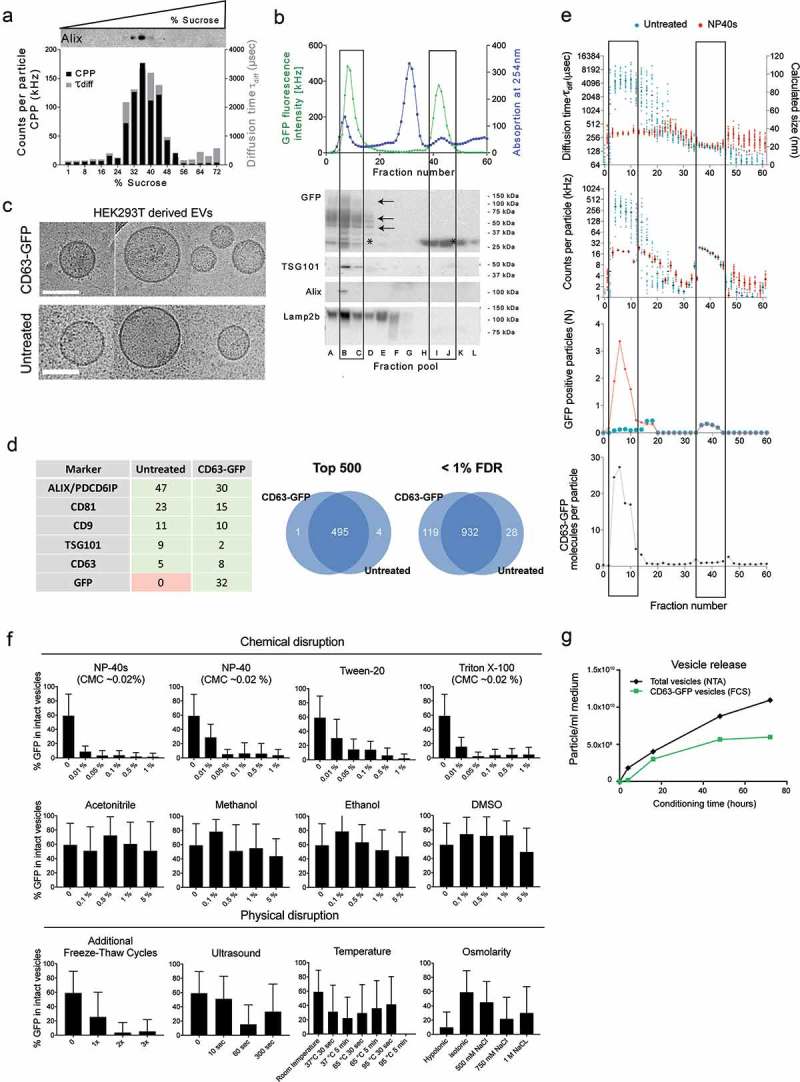
Single molecule – single vesicle characterization of CD63-GFP-tagged extracellular vesicles.(a) Direct sucrose gradient fractionation of conditioned medium from CD63-GFP transfected HEK293T cells without prior ultracentrifugation. X-axis: measured sucrose concentrations in collected fractions. GFP fluorescent particles of ca 50–120 nm diameter (measured by FCS) co-fractionate with the EV marker Alix, peaking at ca 32–36% sucrose. (b) Following UF on a 100 kDa MWCO membrane, enriched medium was loaded onto a Superdex200 column for size exclusion chromatography, with continuous UV detection (blue line). The total GFP fluorescence count rate was measured in each of the 60 fractions by FCS (upper panel, green line). Western blots for different exosomal markers were performed after pooling of 4 fractions each into samples A-L as indicated, omitting one fraction in between pools. CD63-GFP fusion protein bands (multiple glycosylated isoforms) versus truncated GFP bands detected on an anti-GFP western blot are indicated by arrows and asterisks, respectively. (c) Cryo-EM analysis of UF-SEC isolated CD63-GFP versus native EVs (representative images). Scaling bar: 100 nm. (d) Left panel, LC-MS proteomics of native versus CD63-GFP HEK293T EVs. Spectral counts for a subset of proteins from the list in Table S1 are shown. Right panel, Venn diagram comparing the top 500 proteins, ranked by total spectral count (left), or all proteins detected at a < 1% false discovery rate (FDR) (right). (e) Individual fractions from size exclusion chromatography of HEK293T CD63-GFP EVs in Figure 1(b) were analysed by FCS with (red data points) and without (blue data points) vesicle disruption by the detergent NP40s. The translational diffusion time (τdiff, upper panel left y-axis and conversion into hydrodynamic diameter, right y-axis), molecular brightness (CPP, second panel) as well as absolute number of fluorescent molecules within the confocal volume (N, third panel) are depicted across the fractions. The ratio of freely diffusing GFP fluorescent particles before and after NP40s treatment (third panel) yields the average number of CD63-GFP molecules per particle (bottom panel). Frames indicate fractions comprising the two main fluorescent populations: the first indicates a heterogenous population comprising mostly GFP-tagged EVs, whereas the second one consists of monomeric GFP. (f) Disruption of EVs (stored at −80°C) with different mechanical and biochemical treatments based on the fraction of intact vesicles versus free GFP measured by FCS. (g) Time course of CD63-GFP vesicle release. The concentration of CD63-GFP positive vesicles in UF enriched samples from HEK293T cells was determined by FCS, the total number of vesicles between 70 and 140 nm in size was determined by NTA. Time points represent hours of conditioning, starting 5 h after transfection.